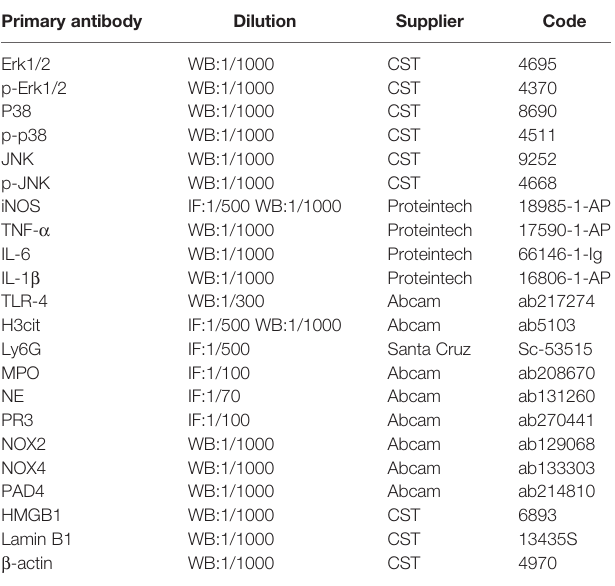
TABLE 2 | Antibody for immuno fl uorescence staining and Western blot. Primary